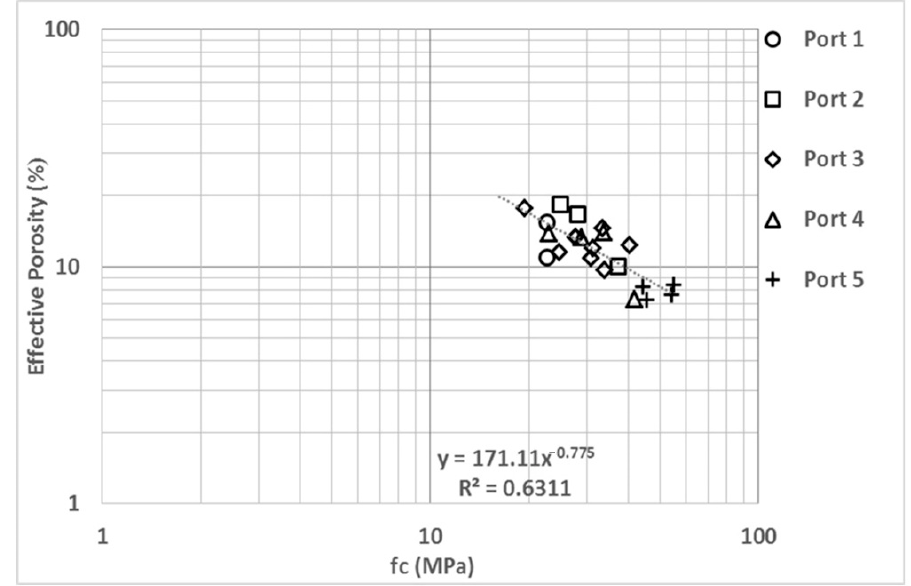
Figure 8. Effectiva porosity (EP) vs. compressive strength (fc).